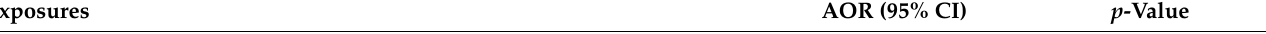
Table 4. Effects of combined coverage of MNP effective coverage and deworming on the prevalence of